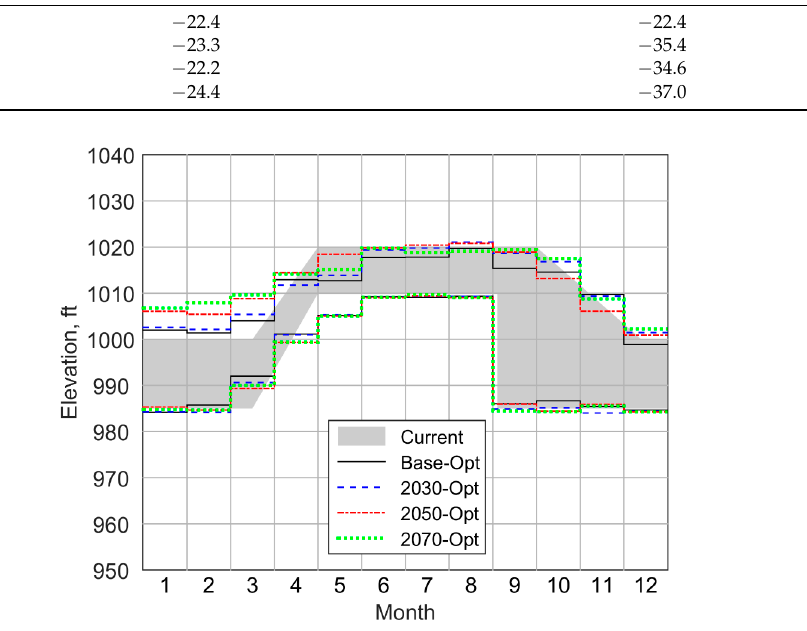
Time Span ∆ Penalty from Current when Using Base-Opt (%) ∆ Penalty from Current When Using GCM-Opt (%)